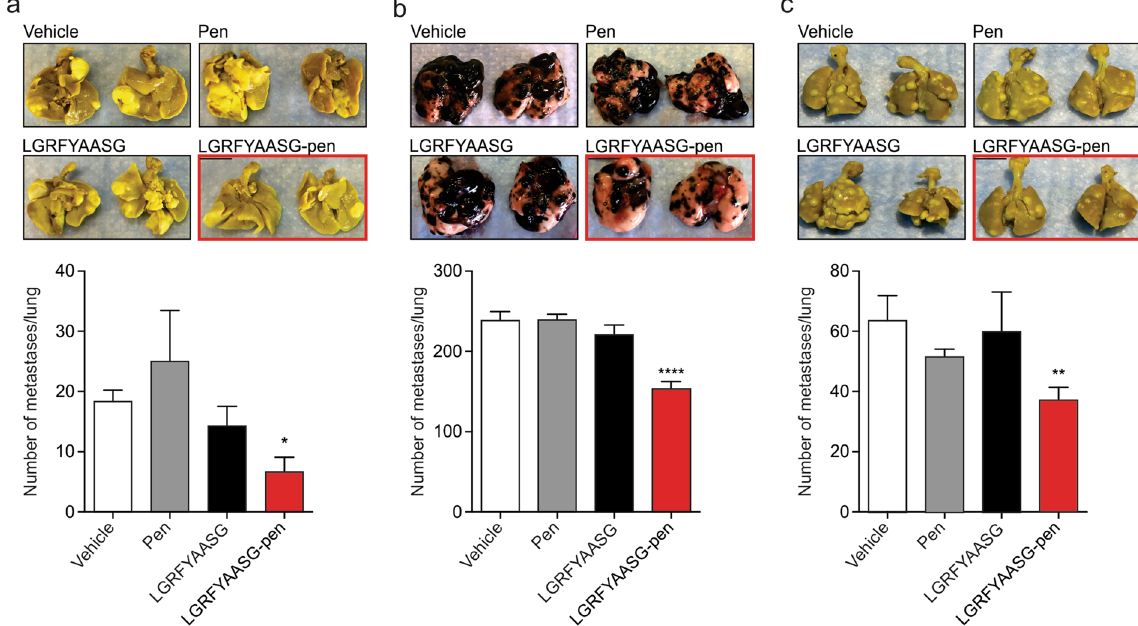
Figure 5. LGRFYAASG-pen inhibits the growth of experimental tumors in several preclinical models. Representative gross morphology of lungs explanted after 8 weeks (KRIB, ( a ), 21 days (B16F10, ( b ), 13 days (LLC, ( c ) after fixation in Bouin’s fixative, and corresponding lung weights (n = 8 animals/group) shown as mean ± SEM ( **** P < 0.0001, ** P < 0.001, * P < 0.01 versus vehicle experimental